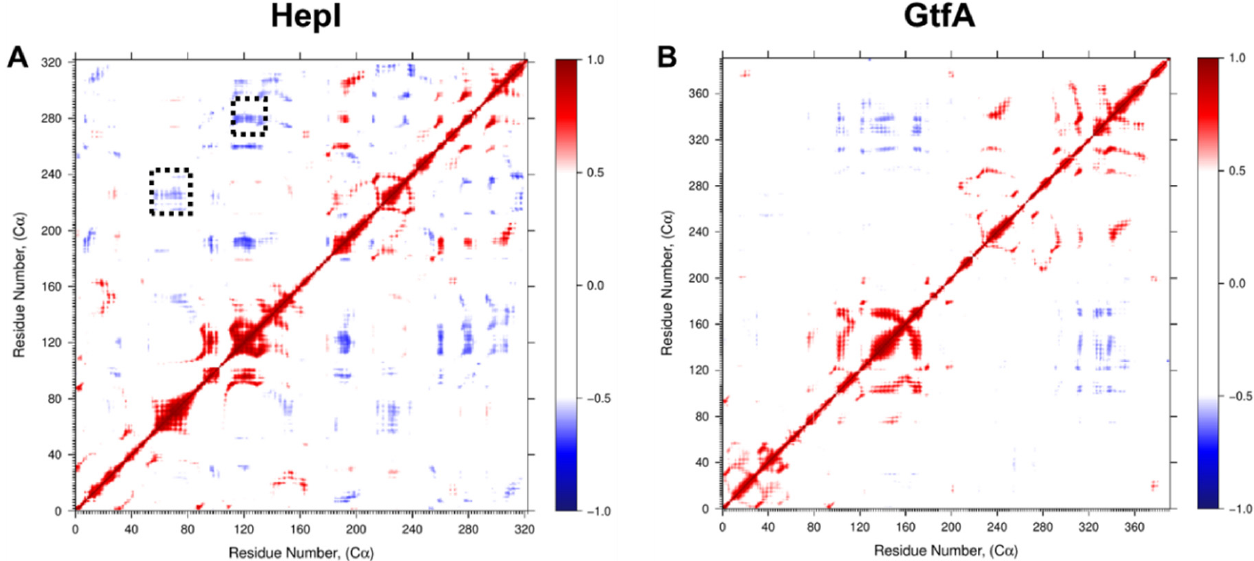
Figure 5. Dynamic C α residue cross-correlation (DCC) of residue fluctuation over 1.2 µs MD simulation showing positively correlated (red), negatively correlated (blue), and uncorrelated (white) regions of ( A ) HepI and ( B ) GtfA. Dotted black boxes denote 60 and 120 s loop regions identified for mutagenesis.